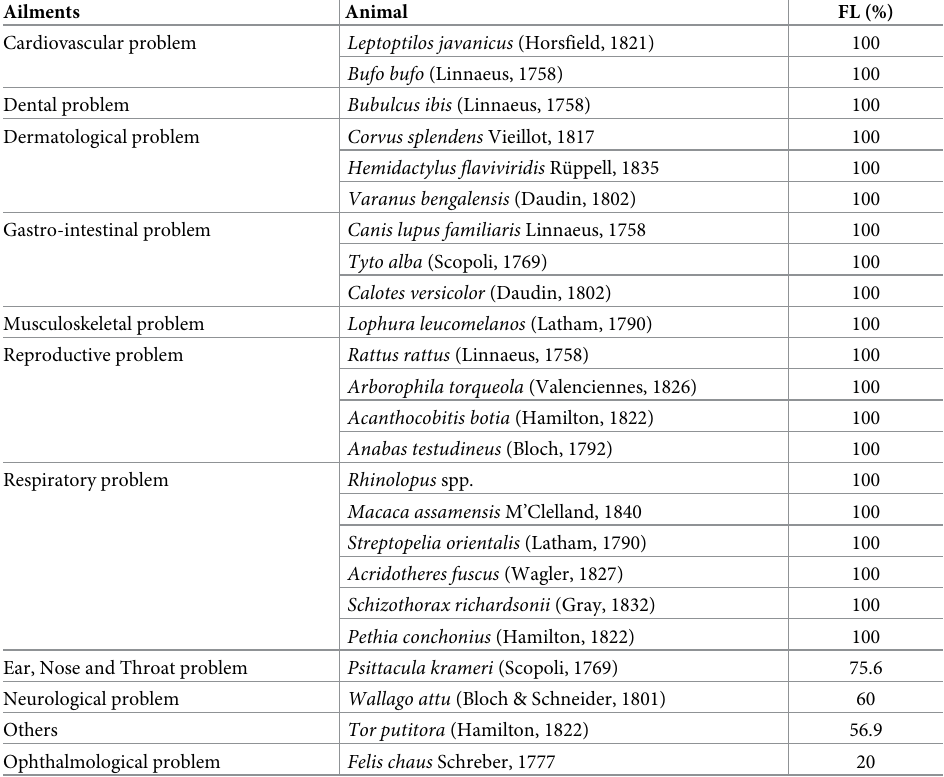
Table 5. Most frequently used animal(s) for different ailment categories based on the highest FL (%) in each ail- ment category.